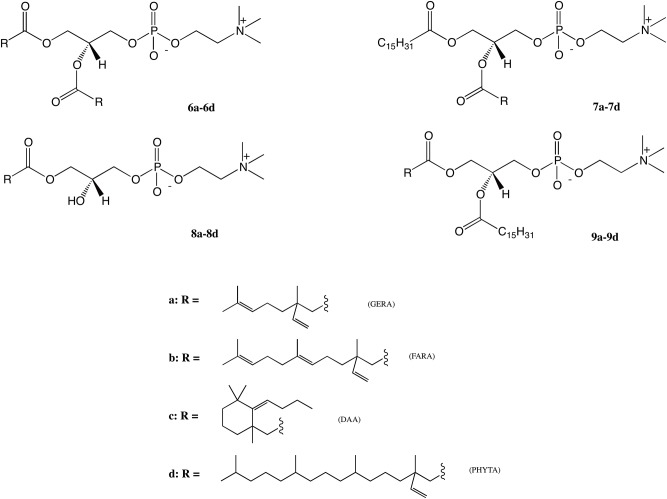
Structures of synthesized isoprenoid phospholipids.